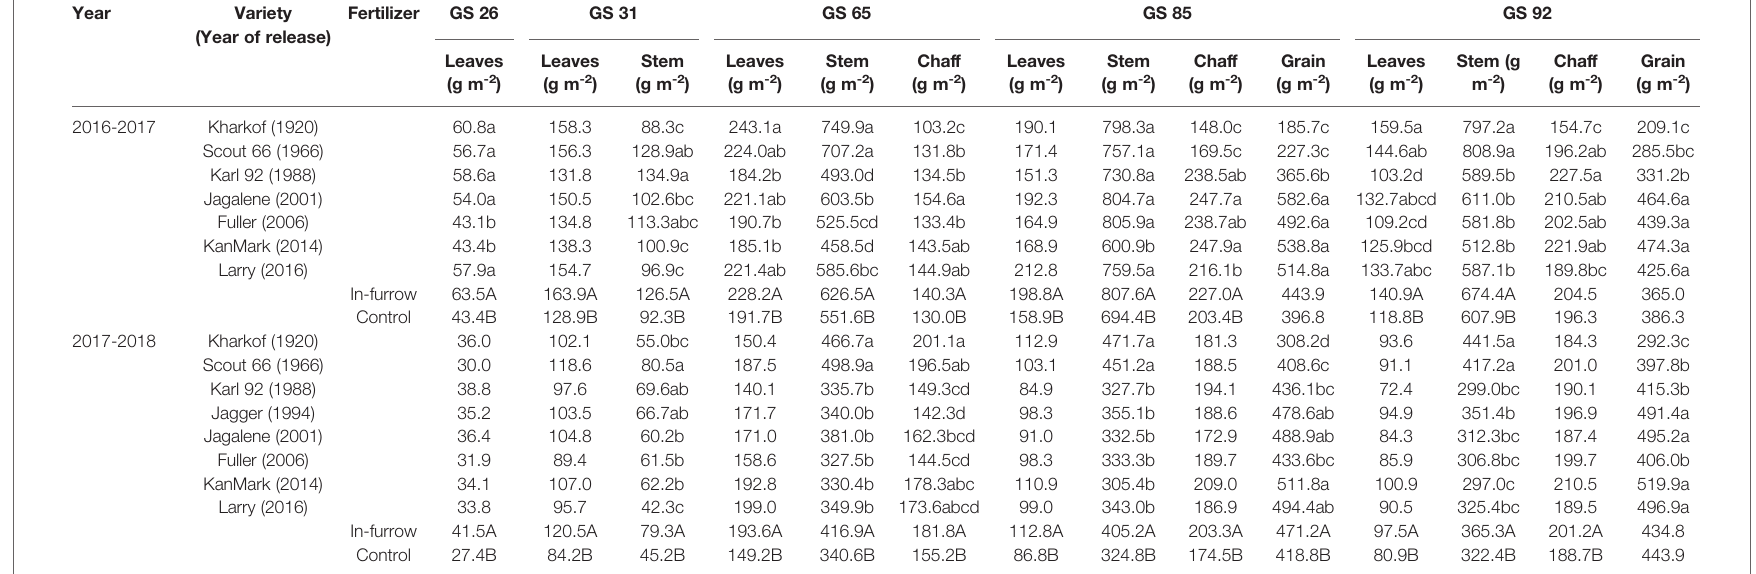
TABLE 4 | Shoot biomass in different plant components (leaves, stem, chaff, grain) at Zadoks 26, 31, 65, 85, and 92 of wheat varieties released between 1920 and 2016, fertilizer treatment, and their interaction during the growing seasons 2016-2017 and 2017-2018. Variety and fertilizer means were averaged across locations within growing season.